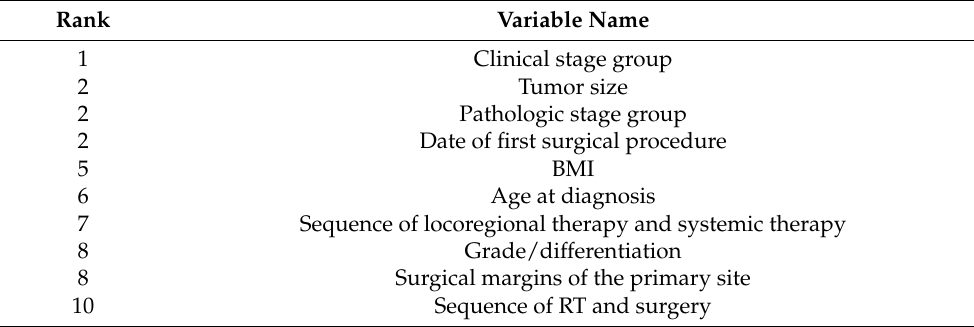
Table 1. The important variables associated with endometrial cancer.